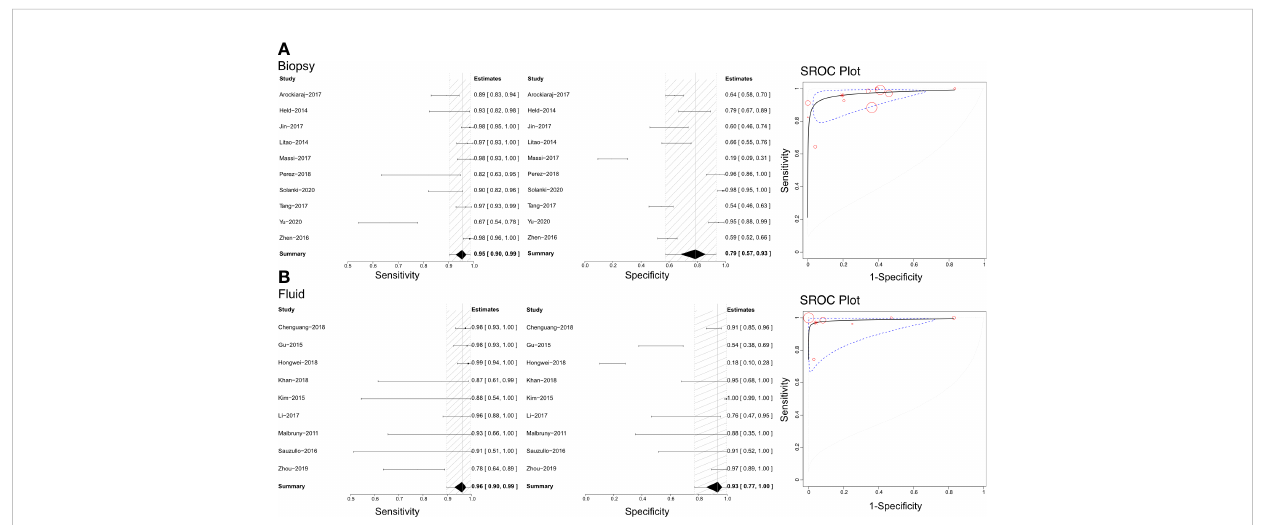
FIGURE 3 The sensitivity, speci fi city and SROC curve of different samples for diagnosing bone and joint TB. (A) The diagnostic ef fi ciency on biopsy sample based Xpert analysis; (B) The diagnostic ef fi ciency on joint fl uid sample based Xpert analysis.